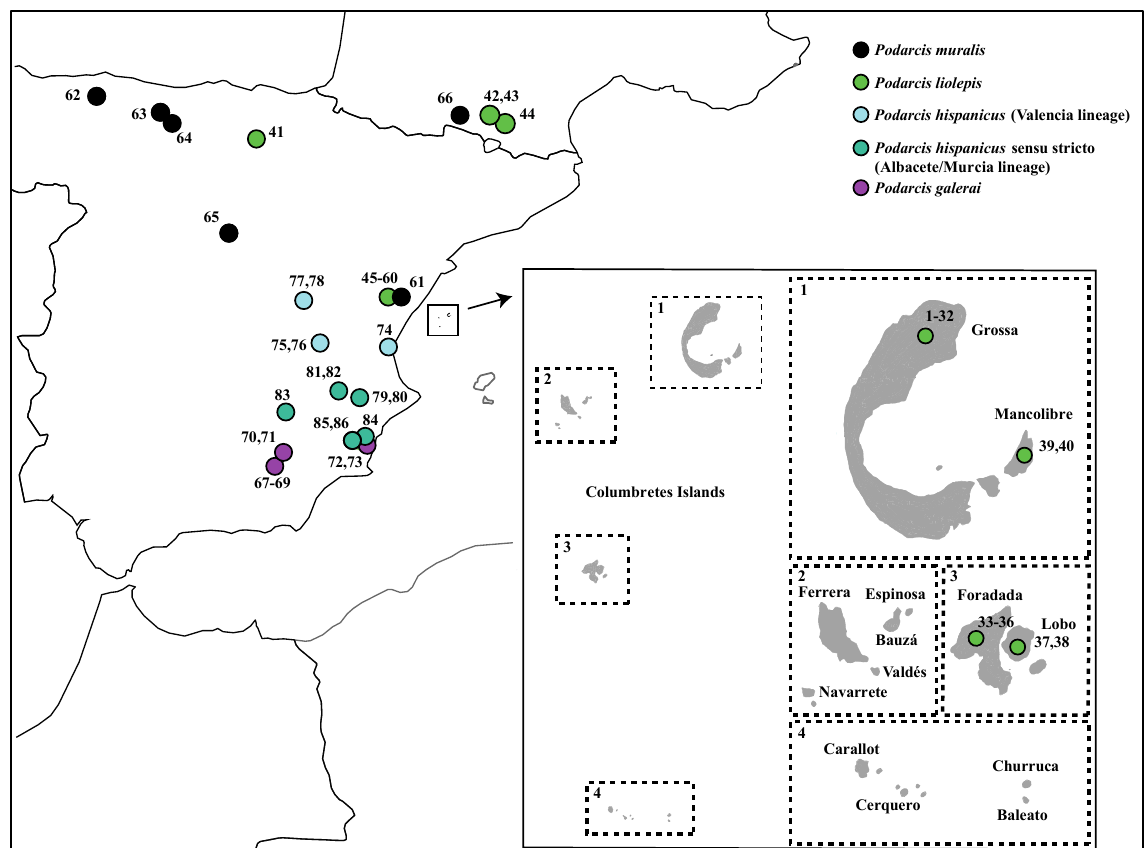
Figure 1. Location of all samples used in this study. The numbers correspond to those in Table S1 and the colours correspond to different species indicated in the legend.